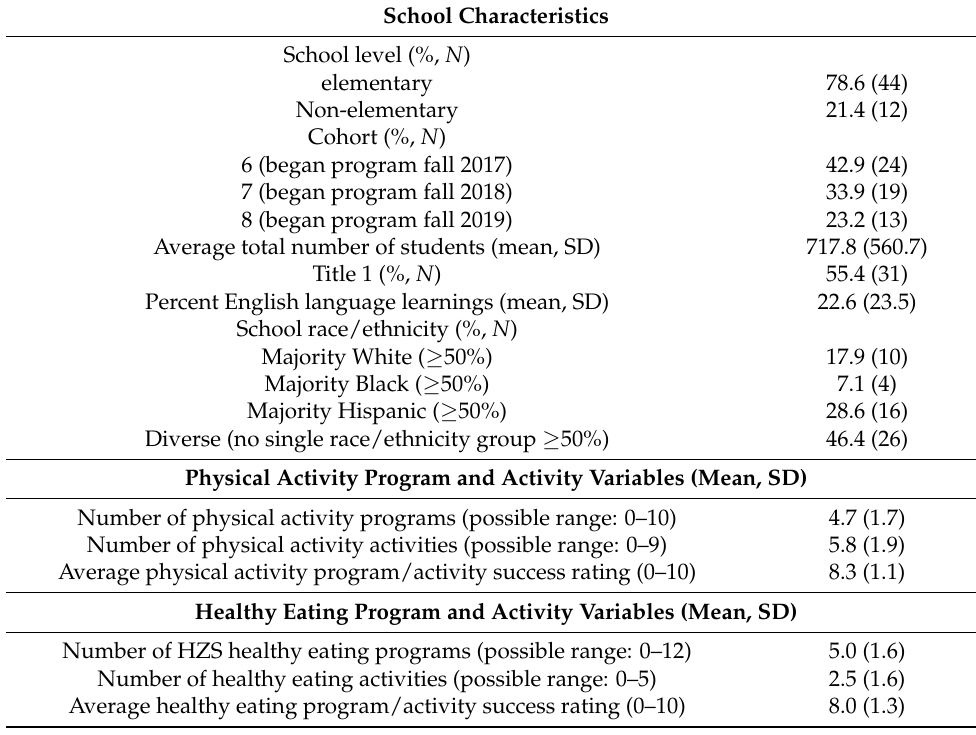
Table 4. Descriptive Information for Healthy Zone Schools (total sample = 56